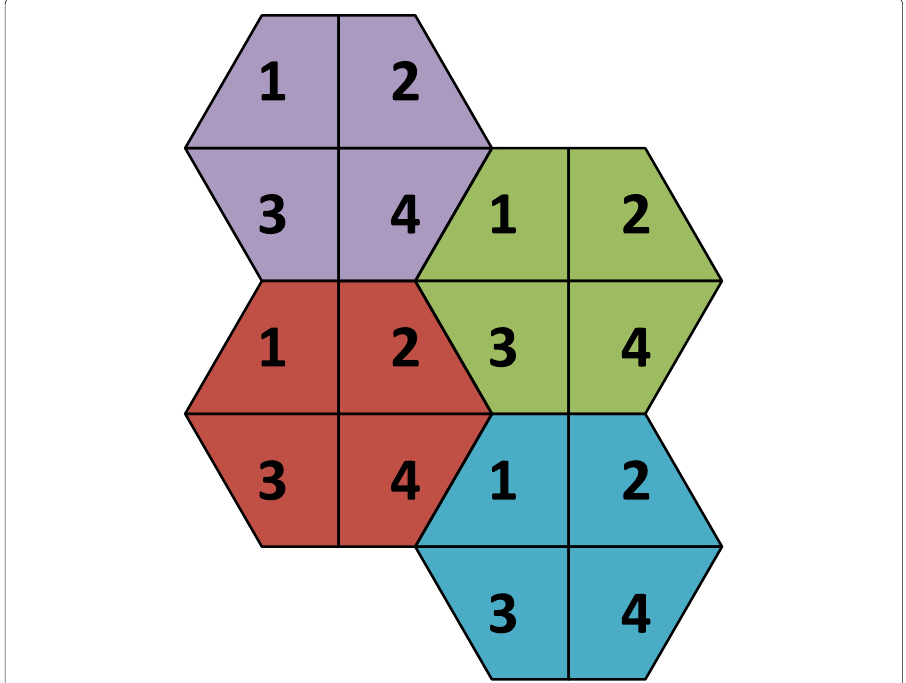
Fig. 4 Beams are divided into four sectors. The sectors with the same numeration are served at the same